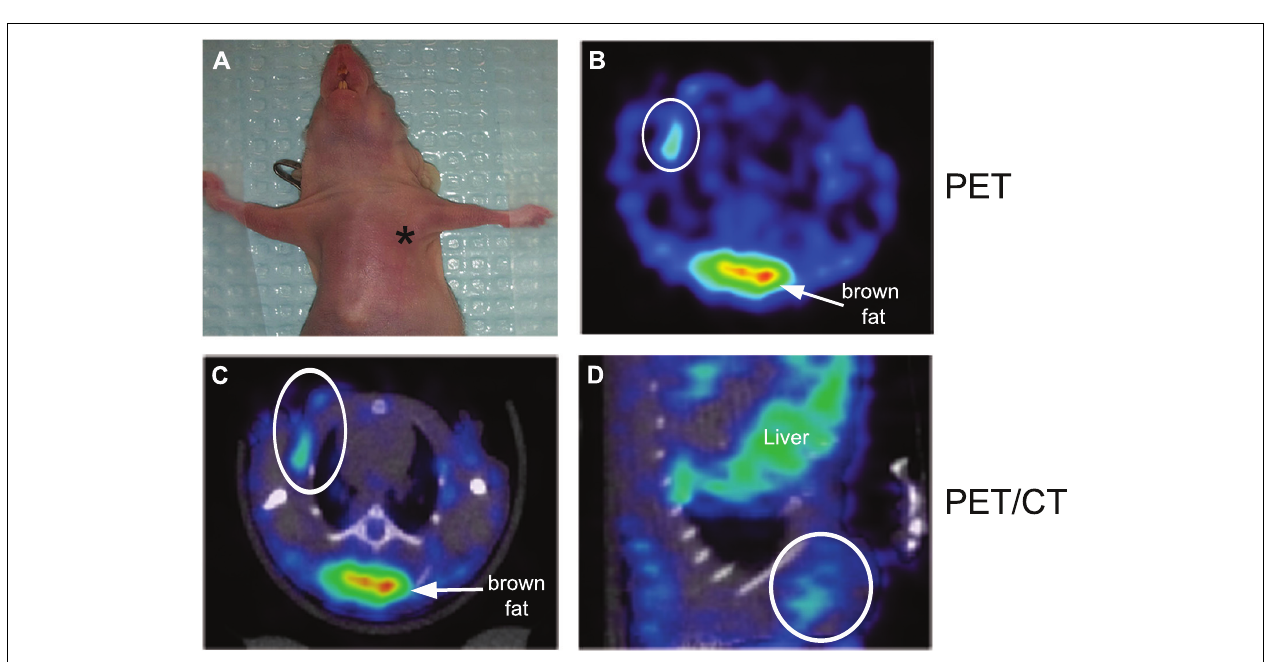
FIGURE 4 | In vivo microPET imaging of COX2 in a tumor-bearing mouse model. At the time of imaging, tumor size was approximately 4 mm in diameter (*, tumor) (A) . Representative PET image of an axial section showing tumor uptake of 18 F-COX2 probe (white circle) (B) . Fused PET/CT axial image (C) . Fused PET/CT sagittal view of the tumor (D)